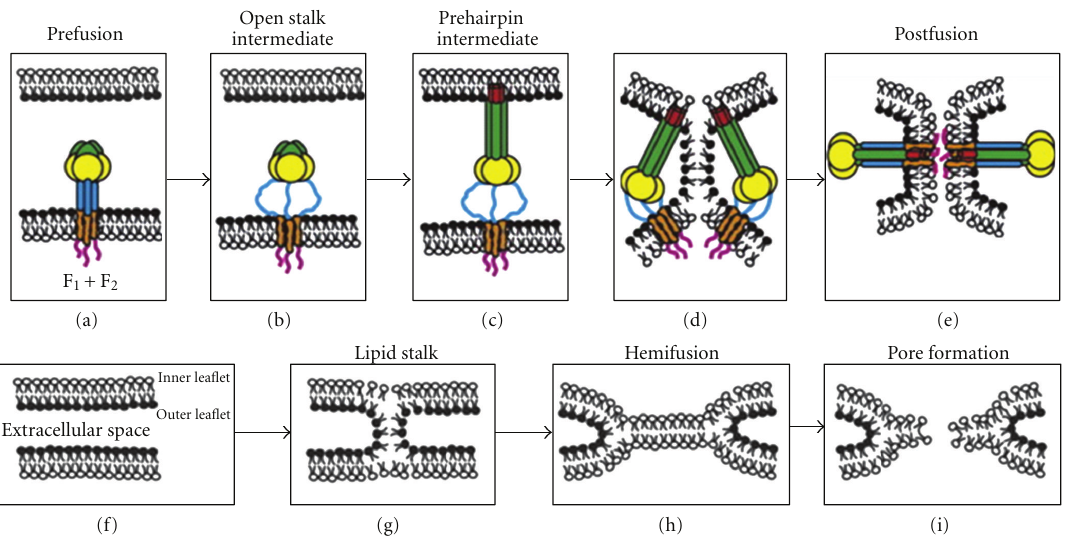
Figure 1: (a) The prefusion form of F contains a globular head with the HRA region in 11 distinct sections, and the HRB region is in a three- helix bundle. The F TM domain is also represented as a three-helix bundle, consistent with the oxidative cross-linking data. (b) Upon HN binding to target cells (HN not shown for clarity), F is activated for fusion, and the HRB region separates, forming the open-stalk conforma- tion where N-1 peptide can bind to HRB. At this open-stalk stage, the TM domain is still thought to be in a three-helix bundle because N-1-HAt can still bind to HRB after the addition of the oxidative cross-linker. (c) After formation of the open-stalk conformation, HRA re- arranges to form the extended α -helical bundle, and the FP is inserted into the target cell membrane (the prehairpin intermediate). (d-e) Finally, the postfusion state occurs with the formation of the 6-HB. (d-e and f–i) Lipid intermediates in fusion with the F protein, removed for clarity. The two bilayers contain an inner and outer leaflets and are separated by the extracellular space. During the process of F refolding to form the postfusion form, water is excluded from the extracellular space and the outer leaflets initially merge to form the lipid stalk inter- mediate. The lipids of the bilayers mix, forming the hemifusion intermediate, and then the fusion pore forms. F domains: FP (red), HRA (green), globular head (yellow), HRB (blue), TM domain (orange), cytoplasmic tail (pink). (From Bissonnette et al., 2009 [44] with permis-